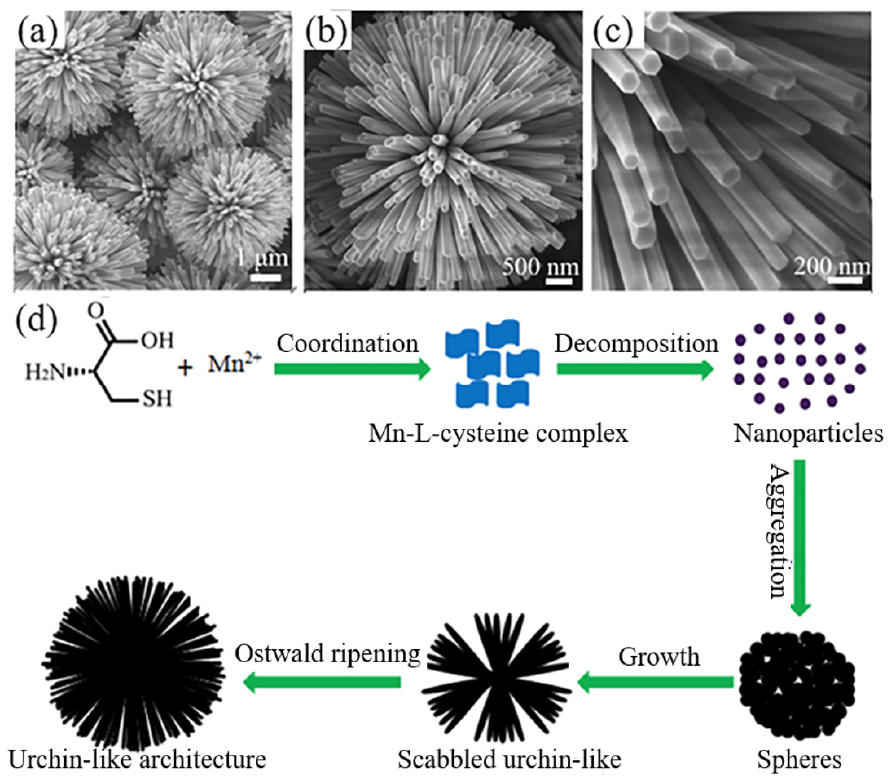
Figure 2. FESEM images of the as-prepared urchin-like γ -MnS architectures: ( a ) high-magnification SEM image, ( b ) enlarged SEM image of an individual urchin-like γ -MnS architecture, ( c ) FESEM image of a few 1D nanorods, ( d ) Schematic illustration of the growth mechanism of the urchin-like γ -MnS architectures [44] (Reprinted with permission from ref. [44]. Copyright 2019 Elsevier).